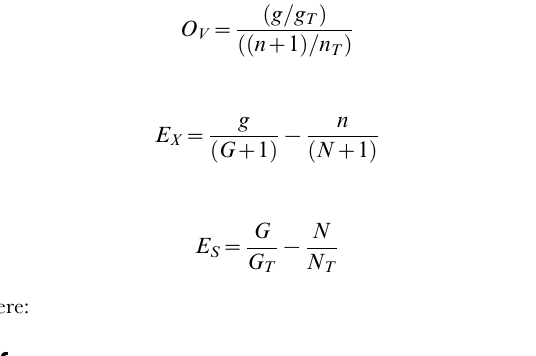
Table S1 Procedure for clustering and identification of unchar- acterized and new families.